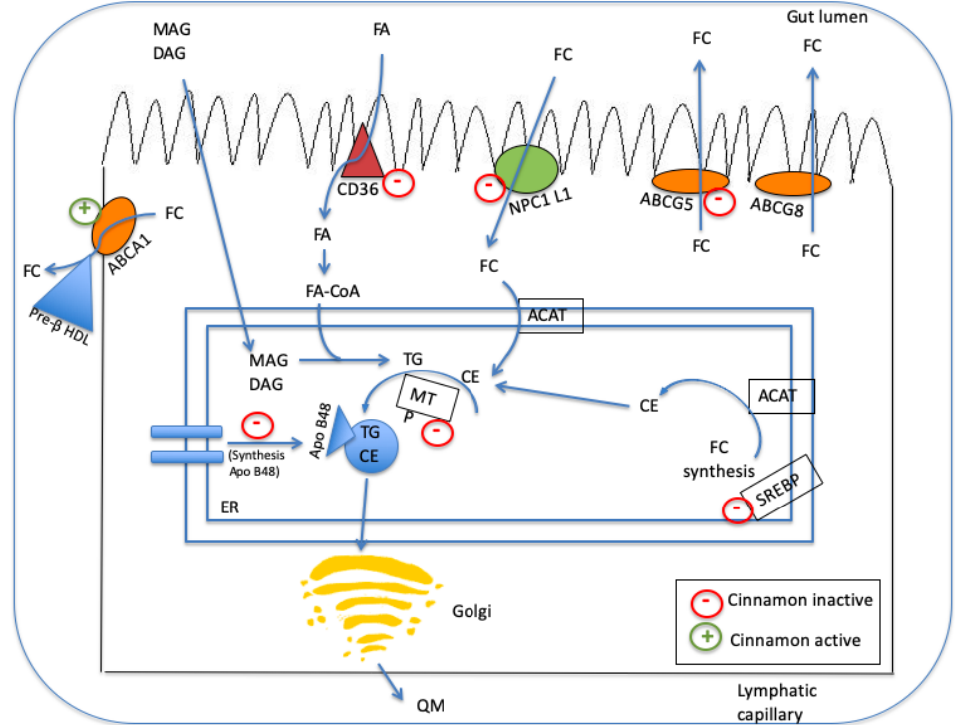
Figure 3. A schematic model describing mechanism(s) of action of cinnamon and its isolated bioac- tive compounds on lipid metabolism in the intestine. Legend: MAG, mono-acylglyceride; DAG, diacylglyceride; FA, fatty acid; FC, free cholesterol; NPC1 L1, Niemann–Pick C1-Like 1; ABCG, ATP-binding cassette sub-family G; ACAT, acetyl-CoA acetyltransferase; TG, triglycerides; CE, choles- terol ester; MTP, microsomal transfer protein; SREBP, sterol regulatory element binding protein; ER, endoplasmatic reticulum. QM, chylomicron.